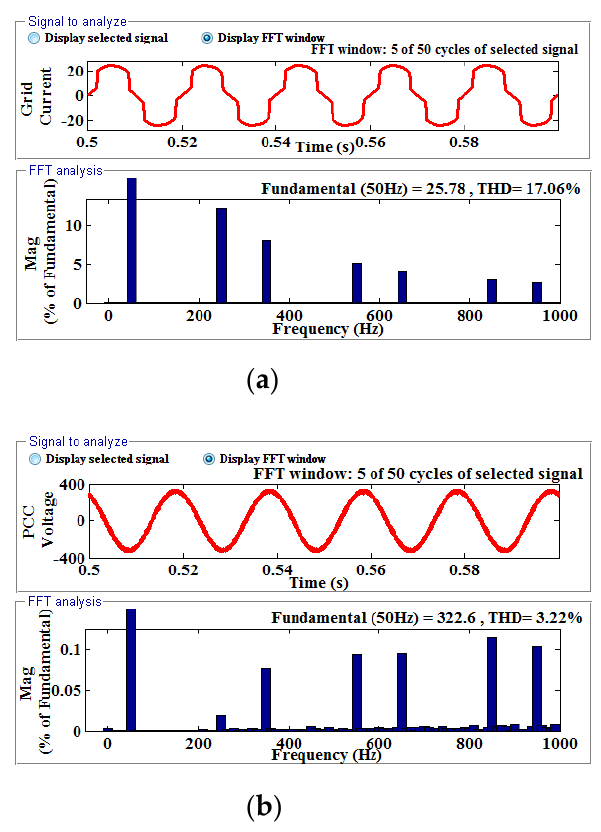
Figure 4. ( a ) FFT analysis of distorted load current/grid current with inductive load, ( b ) FFT analysis of PCC voltage with inductive load.